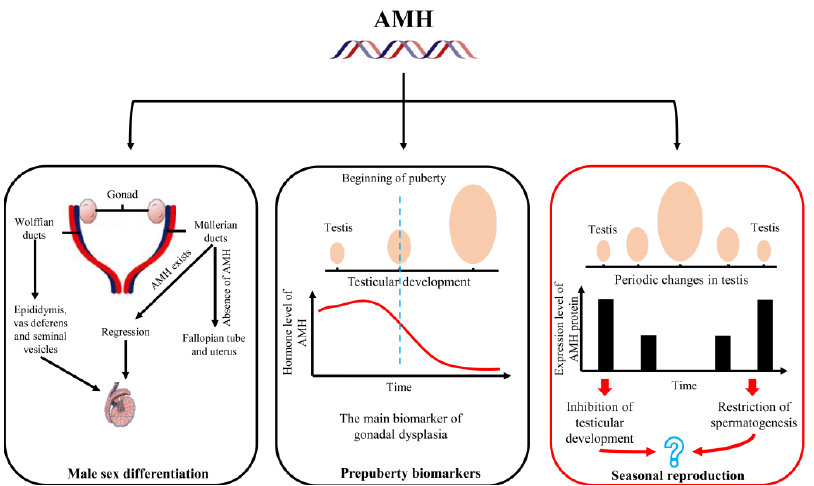
Figure 5. The main research fields of anti-Müllerian hormone (AMH) and its potential research value in the regulation of seasonal reproduction are summarized.